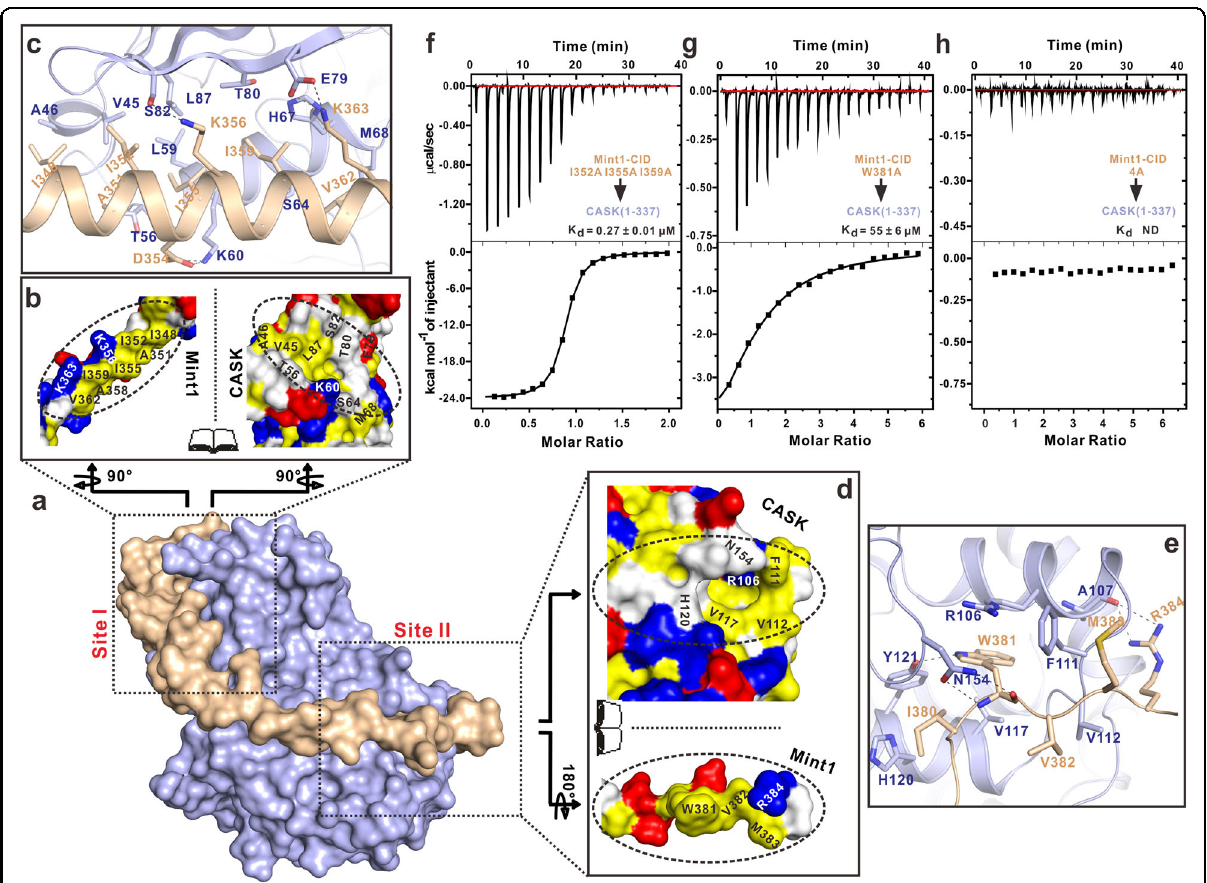
Fig. 5 Interaction interface in the CASK/Mint1 complex. a A surface representation of the CASK/Mint1 complex showing that Mint1-CID wraps around CASK-CaMK. The interaction interface between CASK and Mint1 can be divided into two sites (sites I and II, highlighted by dashed boxes). b , d An “ Open-book ” view of the two interaction sites of the CASK/Mint1 complex by a surface representation. Site I is contributed by the helical packing between the N-lobe of CASK-CaMK and the N-CID of Mint1 ( b ), and site II is mainly contributed by the interaction interface between the C- lobe of CASK-CaMK and the C-CID of Mint1 ( d ). In the drawing, the hydrophobic, positively charged, negatively charged residues and remaining residues are colored in yellow, blue, red and white, respectively. c , e A combined ribbon-and-stick model showing the interface in site I ( c ) and site II ( e ). The side chains of the key residues involved in the interface packing are shown as sticks. f – h Interaction between CASK-CaMK (residues 1 – 337) and Mint1-CID (residues 338-397) mutants measured by ITC assay: ( f ) I352A I355A I359A; ( g ) W381A and ( h )